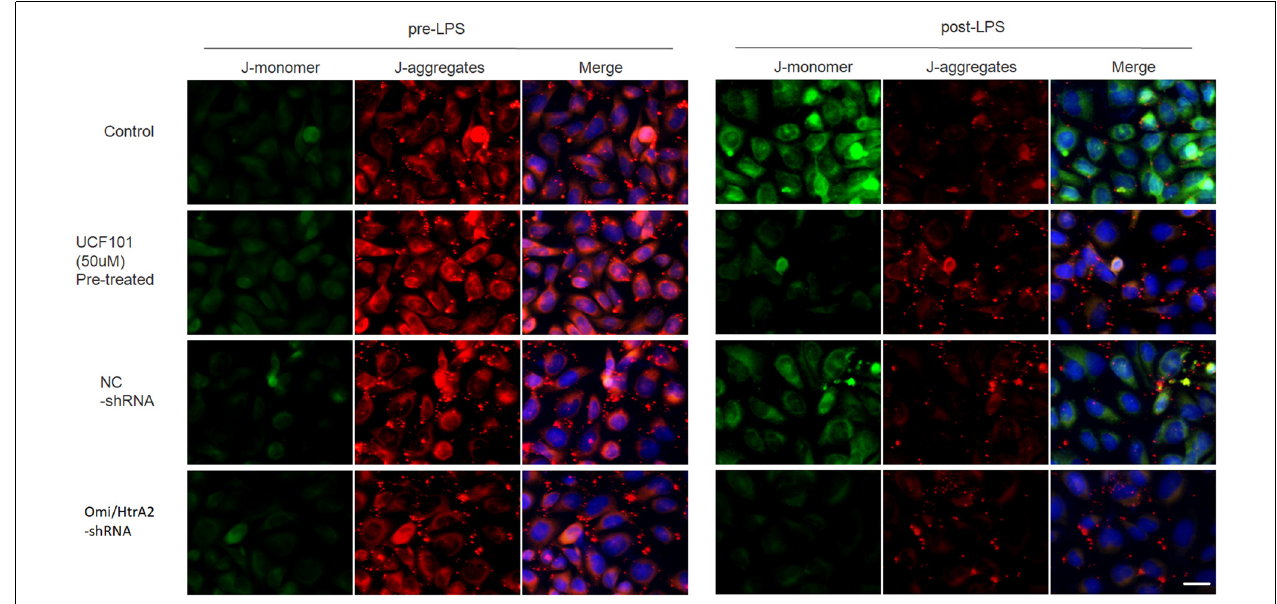
FIGURE 8 | Effects of inhibition of Omi/HtrA2 by UCF-101 or Omi/HtrA2 shRNA on mitochondrial membrane potential (MMP) in LPS-treated hCMEC/D3 monolayers as determined by JC-1 staining using fluorescence microscope. Cells stained with red color indicates high MMP and green color indicates low MMP. Scale bar, 25 µ